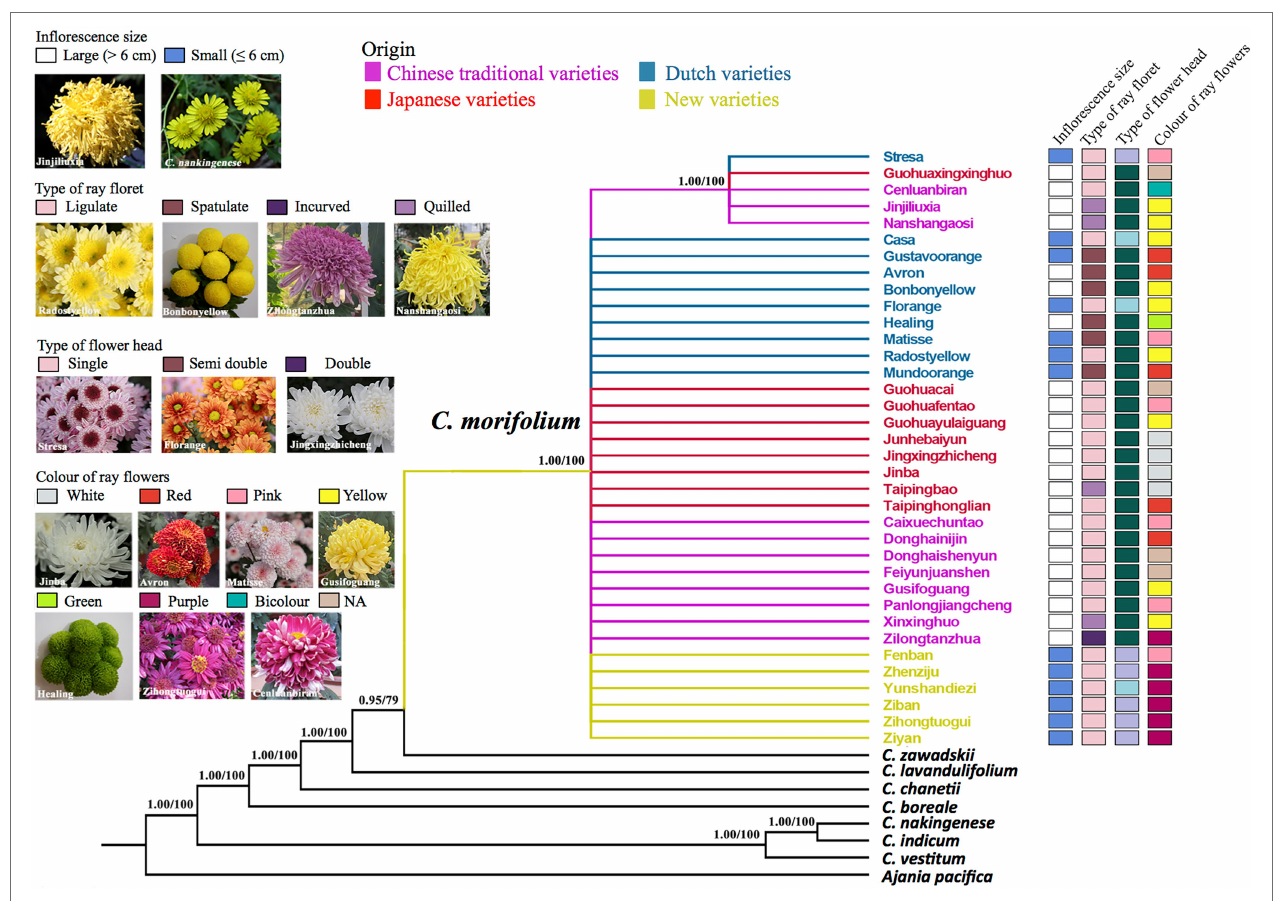
FIGURE 1 | Phylogenetic relationships of chrysanthemums inferred from whole chloroplast genomes. Numbers above the branches are Bayesian posterior probability (PP) and likelihood bootsrap (BS) values. Branches with PP < 0.5 or BS < 50 are collapsed. The cultivar clades and names are indicated in different colors depending on their origin. Cultivar floral traits are showed on the right of the